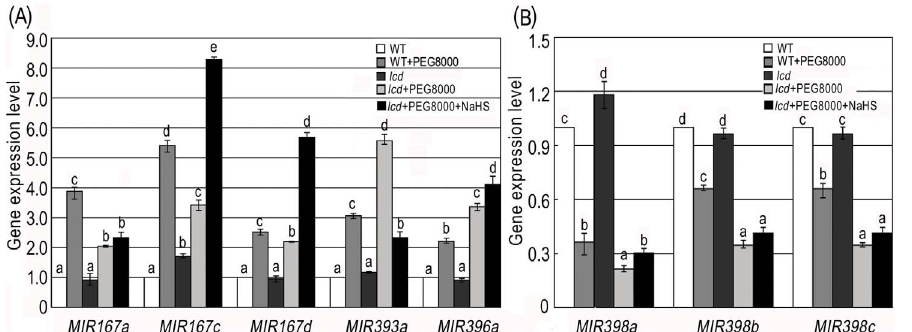
Figure 4. PEG8000 and NaHS effects on miRNAs in WT and lcd plants. ( A ) MIR167a , MIR167c , MIR167d , MIR393a and MIR396a expressions in WT and lcd treated with 50 m mol L 2 1 NaHS and 0.2 g ml 2 1 PEG8000. lcd was pre-treated with 50 m mol L 2 1 NaHS for 12 h and 0.2 g ml 2 1 PEG8000 for 2 h; ( B ) MIR398a , MIR398b and MIR398c expression in WT and lcd treated with 50 m mol L 2 1 NaHS and 0.2 g ml 2 1 PEG8000. The same treatments were applied as in ( A ). ACTIN was used as an internal control in qRT-PCR. Results are shown as mean 6 SE (n=3 independent experiments). Letter numbers indicate significant differences between treatments within one gene ( P , 0.05 ).